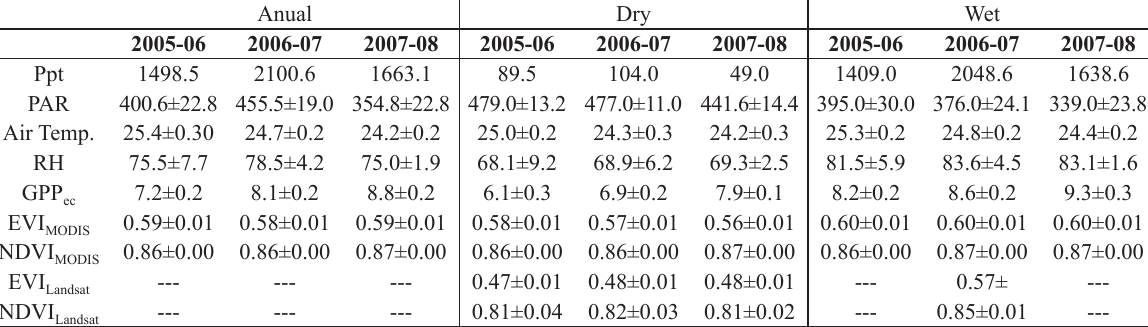
Annual and seasonal accumulated precipitation (Ppt - mm), mean (± standard deviation) of Photosynthetic Active Radiation (PAR – molPAR day -1 ), air temperature (Air temp - ° C), relative humidity (RH